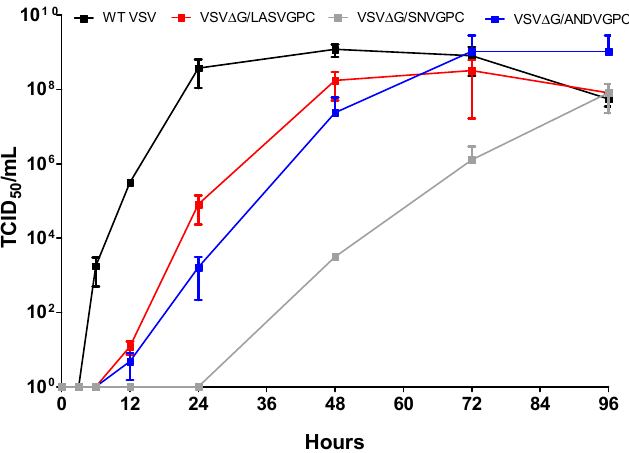
Figure 1. Growth kinetics of different recombinant vesicular stomatitis viruses (VSVs). Each virus was used to infect VeroE6 cells at MOI 10 − 4 for 96 h. The TCID50 / mL of each virus is indicated for each time point. Data shown are mean +